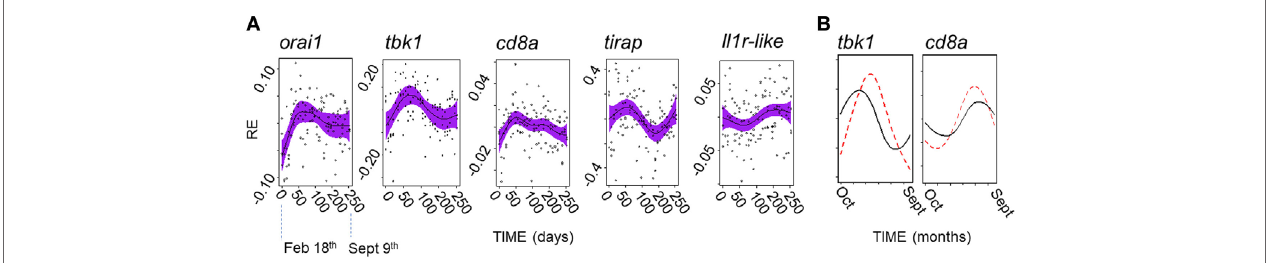
FigUre 7 | A possible endogenous oscillation in gene expression in laboratory-maintained fish ( n = 120). (a) Non-parametric smoothers from generalized additive mixed models (GAMMs) (except where otherwise stated) representing temporal variation in relative gene expression (RE) for laboratory experiment running between February 11th and September 9th 2015. Timings on the x -axis are zeroed at the first sampling point (February 18th). Four genes show peaks ( orai1 , tbk1 , tirap , and cd8a ), and one gene a trough ( ilr1 -like) in spring (April). (Note: the smoother for il1r -like becomes non-significant when a random model term is added, and so represents a tentative trend only; shown is the marginally significant smoother from a generalized additive model, lacking a random term.) Solid lines show (centered) effects on scale of model linear predictor; dashed lines indicate 95% confidence interval; and points are partial residuals. (B) Predictions of RE given host and temperature time series data at FRN 2013–2014; based on cosinor models fitted to the laboratory experiment data, and shown for representative genes (note: tbk1 had the highest sinusoid effect size compared with thermal effect size in the laboratory experiment). Predictions based on thermal term alone (solid line) suggest peaks with timing similar to that observed in the wild (in winter for tbk1 and summer for cd8a ); prediction based on the thermal and cosinor terms (dotted line) shifts peaks toward the